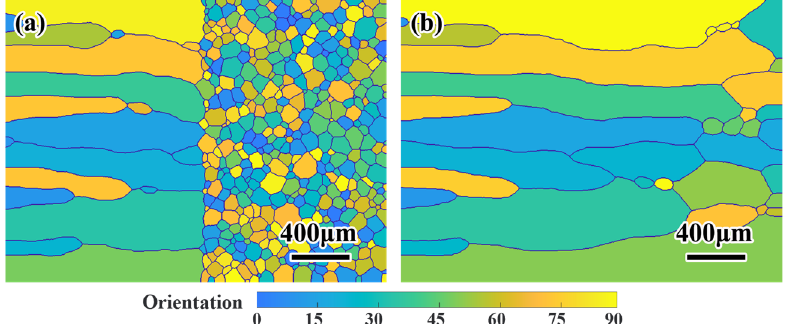
Figure 6. Microstructure evolution of directional annealing at a drawing velocity of 3.3 µ m/s at 900 °C. ( a ) the hot zone passes through half of the specimen, ( b ) the hot zone passes completely through the specimen.